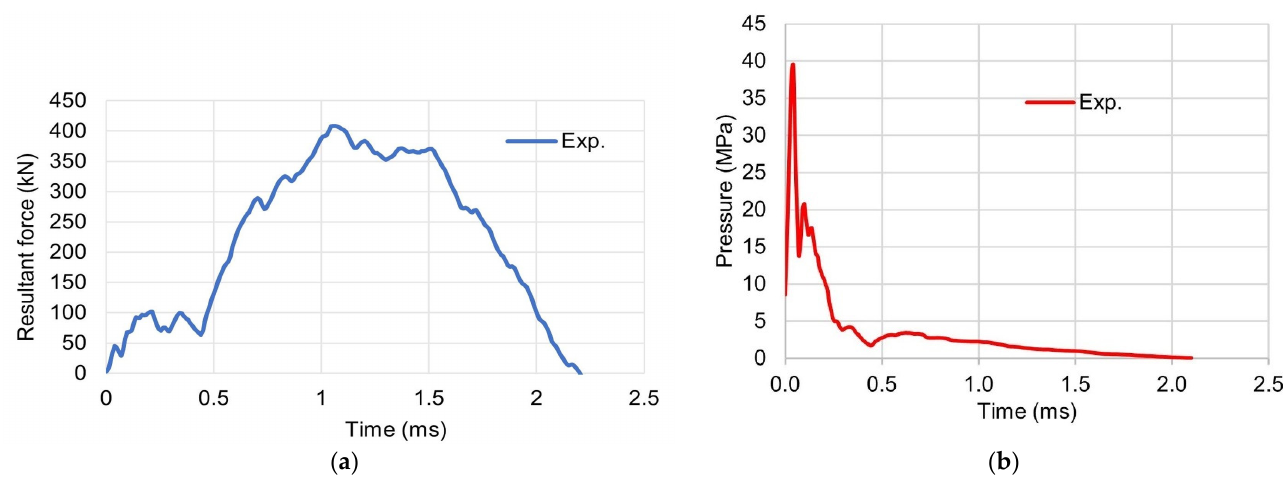
Figure 17. Resultant force ( a ), and pressure ( b ) recorded during shot no. 4.